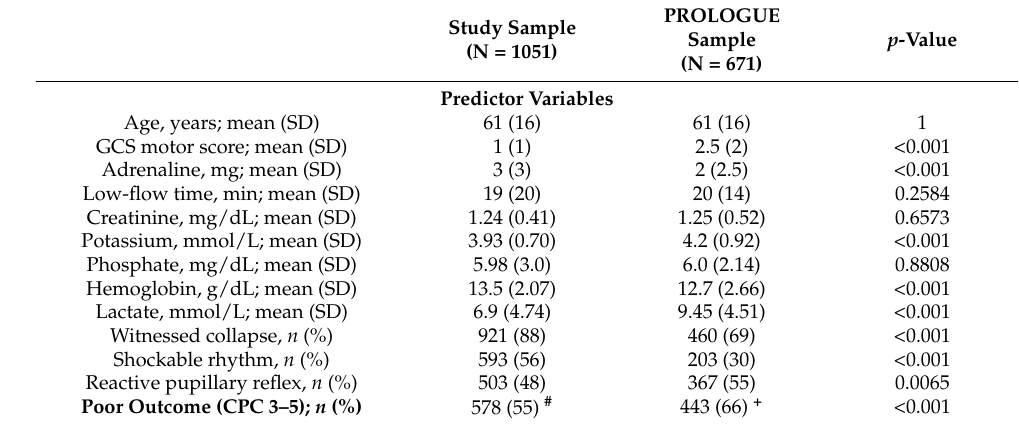
Table 2. Comparisons of predictor variables and event rates between the study sample and the PROLOGUE derivation